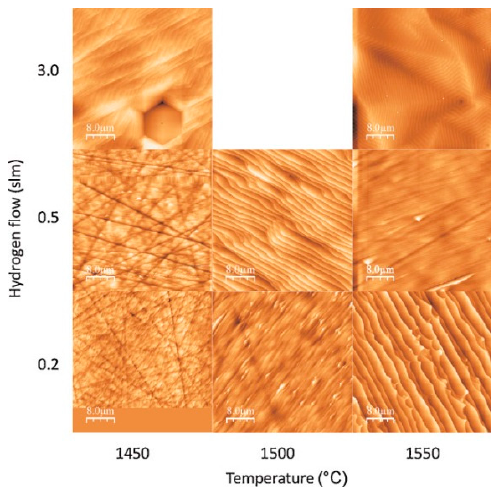
Figure 44. AFM images of hydrogen-etched Si face of SiC surfaces etched with various hydrogen flow rates and temperatures [157].